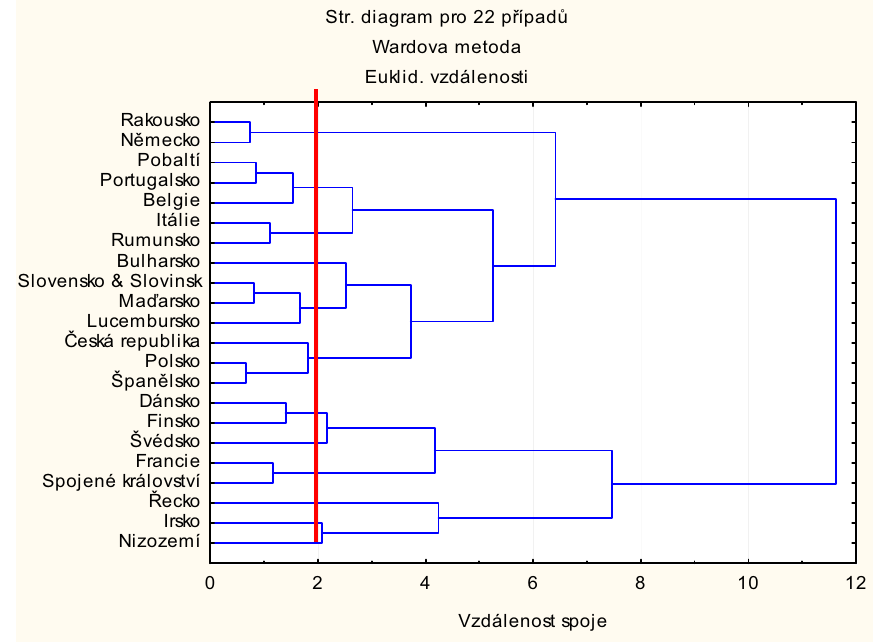
Fig. 1. Dendrogram of cluster analysis